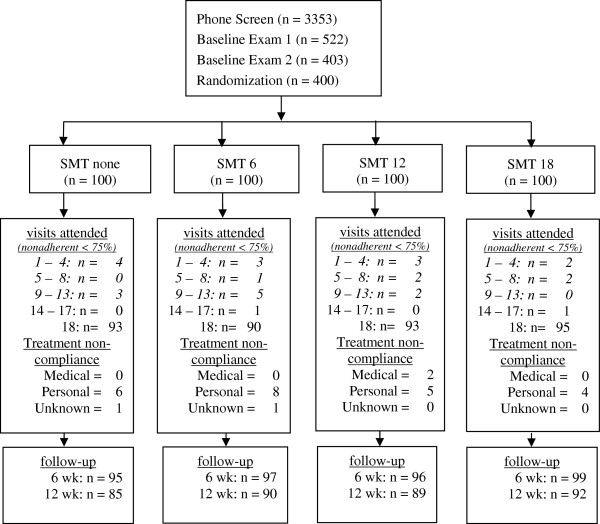
Study flowchart.